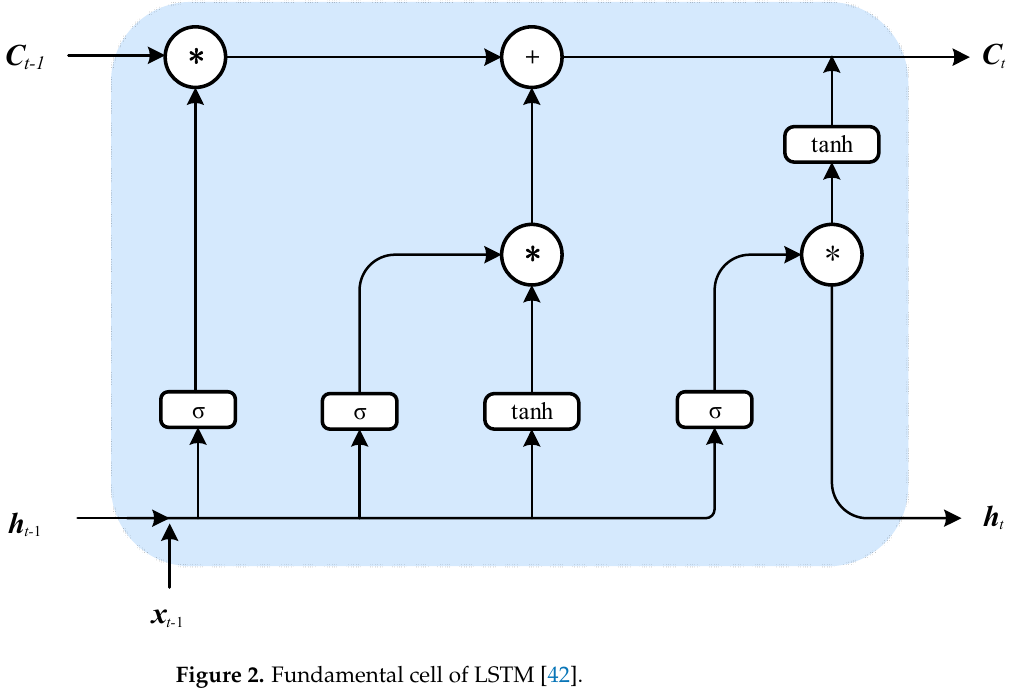
Figure 2. Fundamental cell of LSTM [42].